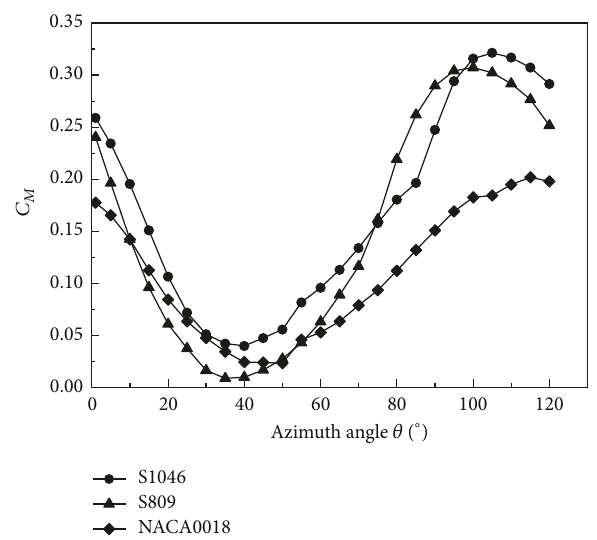
Figure 10: Torque coefficient at different azimuth angle ( 𝜆 = 1.8